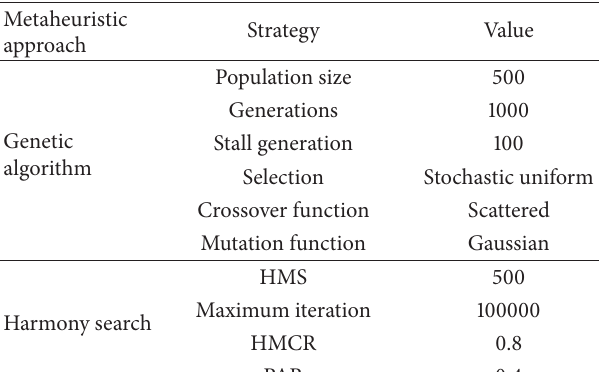
Table 1: Strategy for the GA and HS.